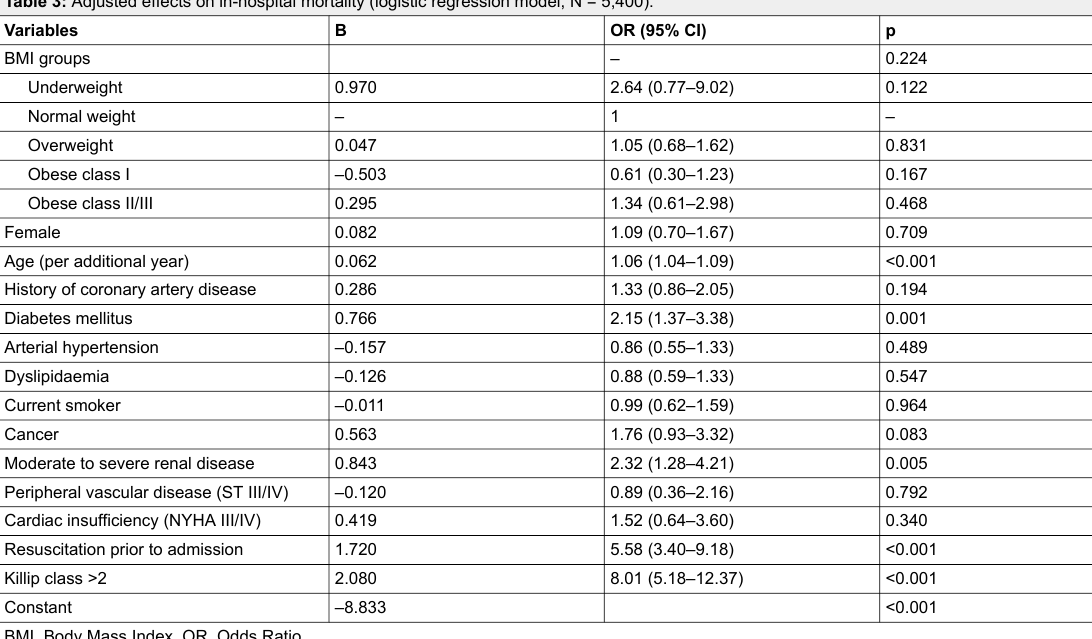
Table 3: Adjusted effects on in-hospital mortality (logistic regression model, N = 5,400).